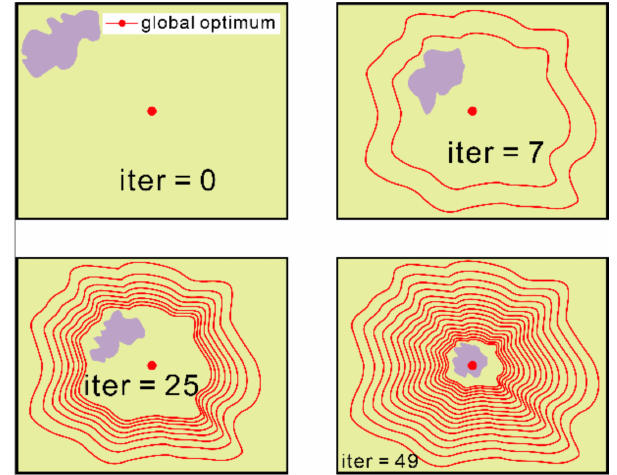
Figure 6. Schematic domain with iterations by the LCS